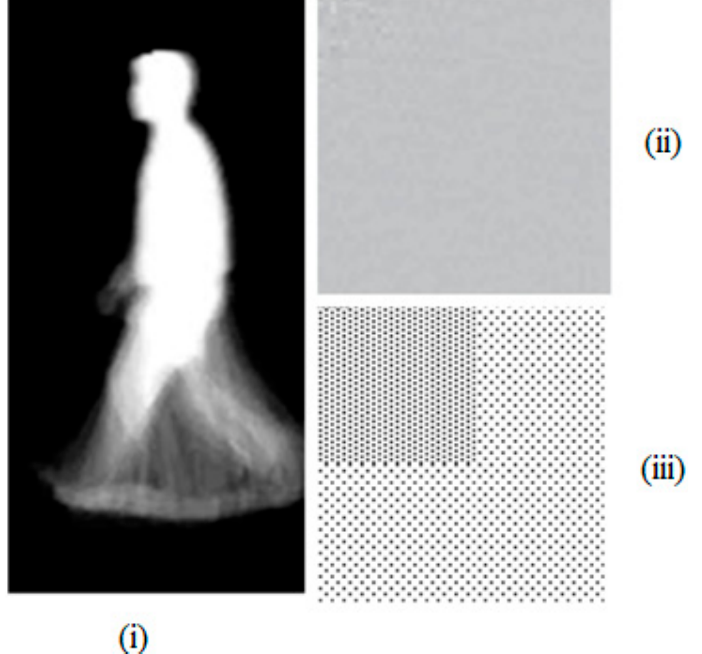
Figure 4. Illustration of DCT — (𝐢) GEI input, (𝐢𝐢) DCT Transform, and (𝐢𝐢𝐢) categorization of DCT coefficient.